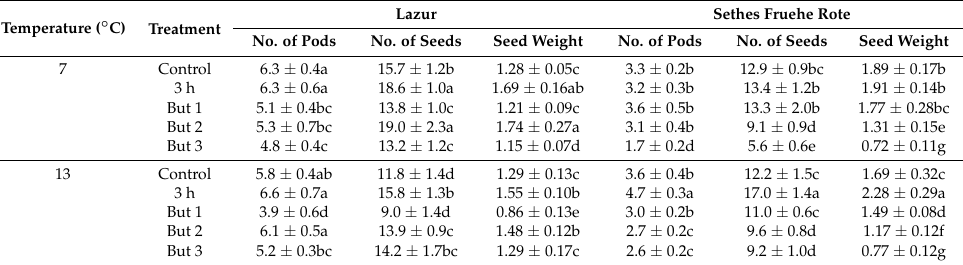
Table 8. Effects of pre-sowing treatments on number of pods, seeds and seed weight (g) per plant of two L. angustifolius cultivars germinated and grown for the first 4 weeks at 7 ◦ C (cold) or 13 ◦ C (control temperature). Control—plants grown from seeds germinated in water; 3 h—plants grown from seeds hydroprimed for 3 h at 20 ◦ C; But 1, But 2, But 3—plants grown form seeds germinated in 10 − 6 M, 10 − 5 M, 10 − 4 M butenolide,